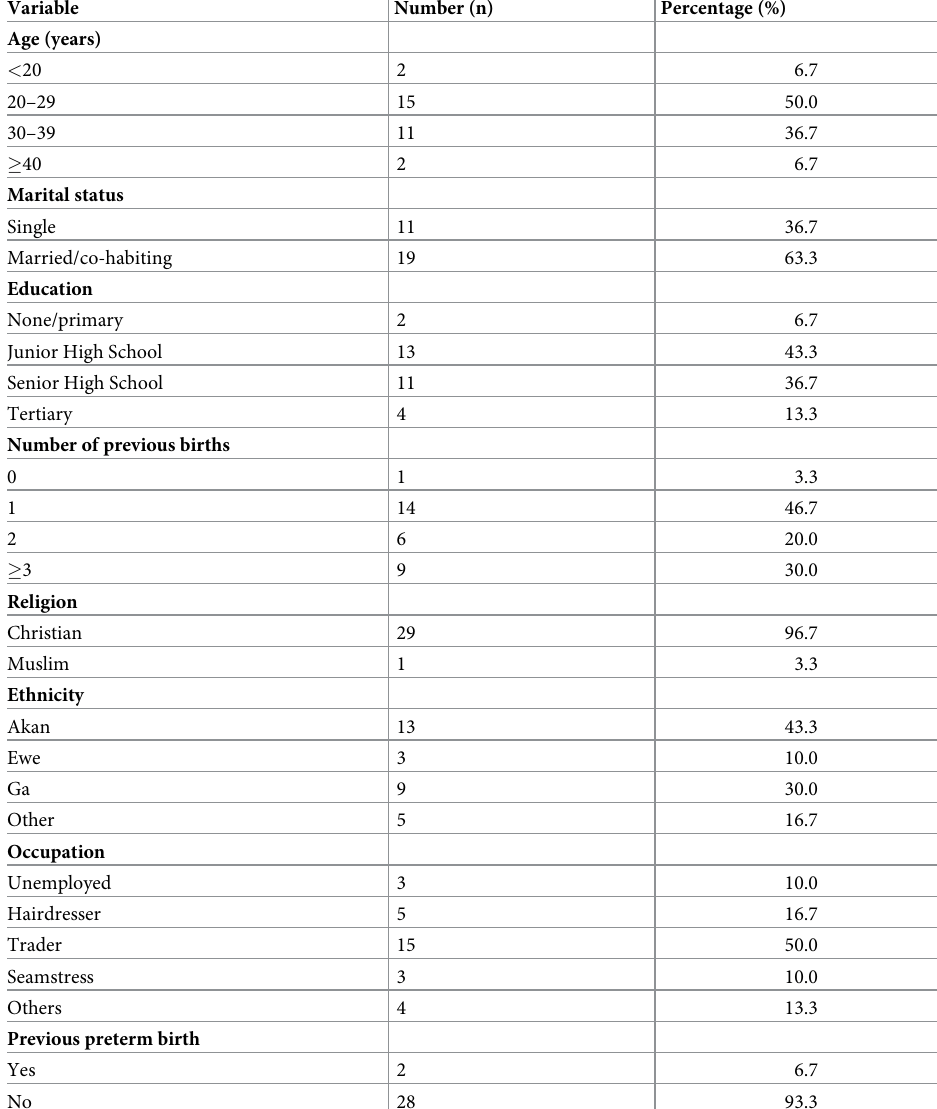
Table 1. Socio-demographic characteristics of women who experienced preterm